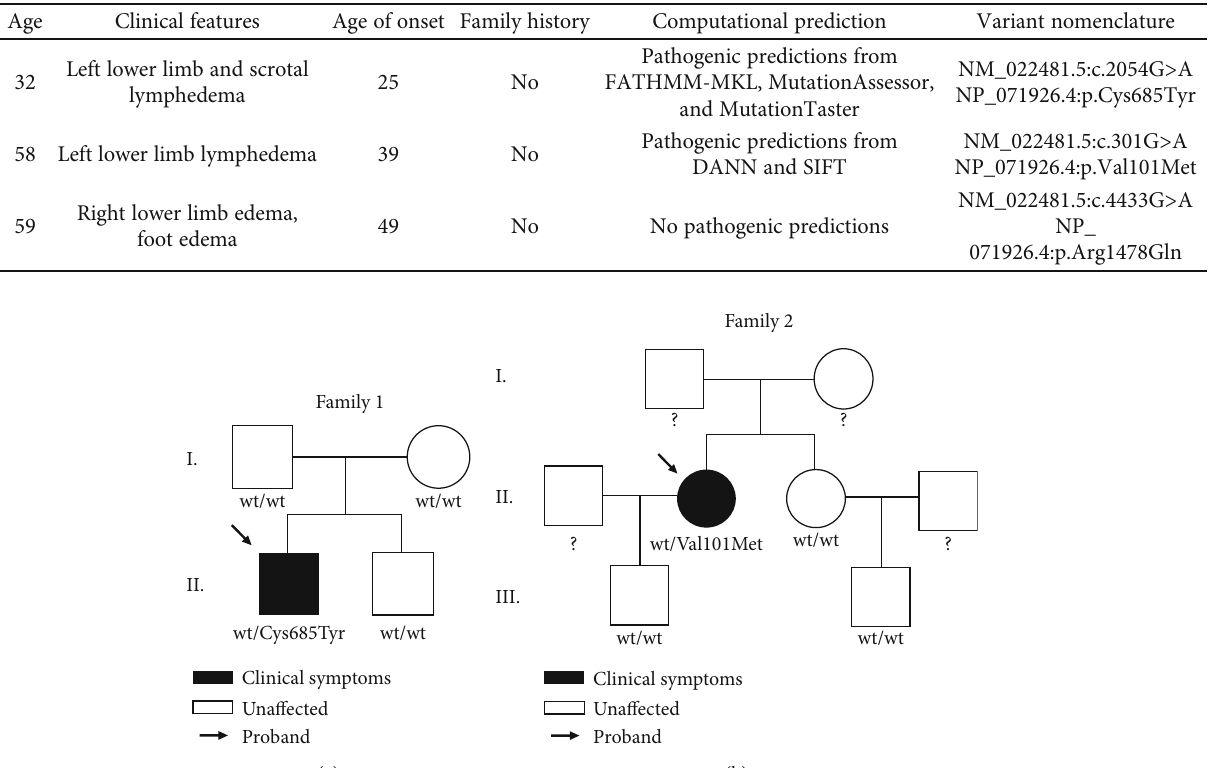
Table 2: Clinical features of the probands.